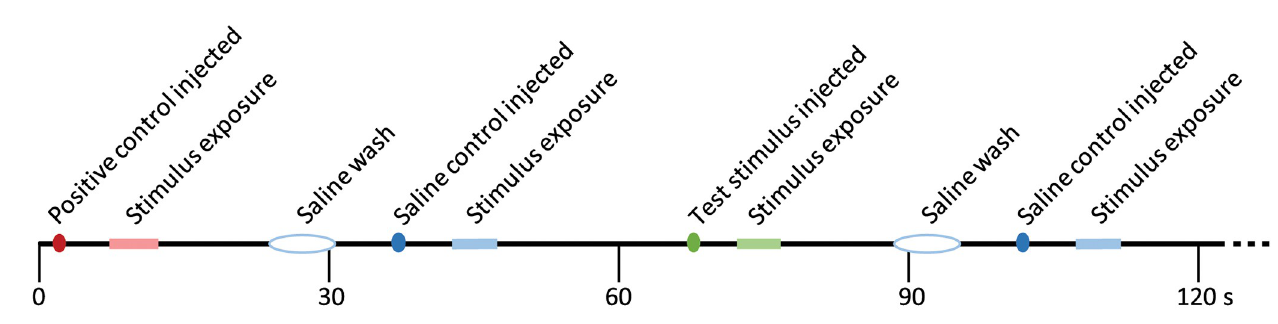
Fig 2. Sample experiment timeline. This timeline represents a short segment of an experiment, illustrating the order and timing of events. Stimuli were injected into a port in the perfusion line (colored dots), traveled down the perfusion line for several seconds, then washed across the olfactory epithelium (“stimulus exposure” period, marked on timeline). EOG responses were observed during this exposure time if evoked by the stimulus. Positive controls (shown in red; amino acids such as methionine and alanine) were used to elicit a strong EOG response at the start and end (not shown) of each recording block. After positive controls or test stimuli, a saline wash was administered to ensure the port and line were clean (white oval). Saline was also used as a negative control (blue). Test stimuli (green) at various dilutions were alternated with negative controls for the bulk of each recording block.